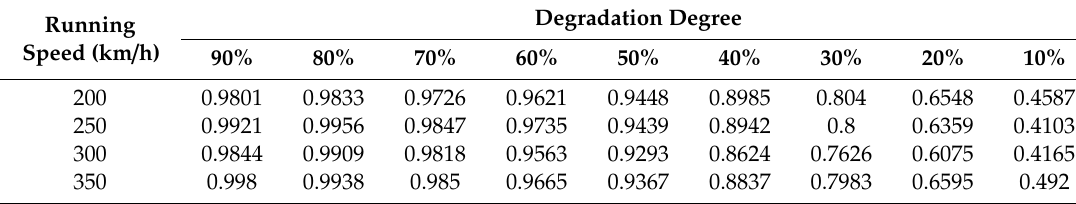
Table 3. WPCC coefficients under different running speeds. Table 4. WPCC coe ffi cients under curve condition.